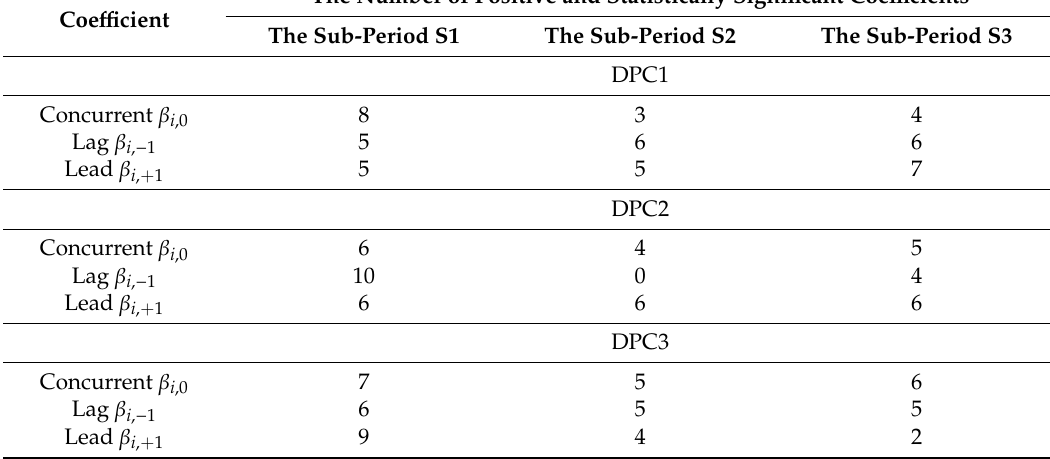
Table 7. The robustness tests for market-wide commonality in liquidity on the WSE over three consecutive sub-periods S1, S2, and